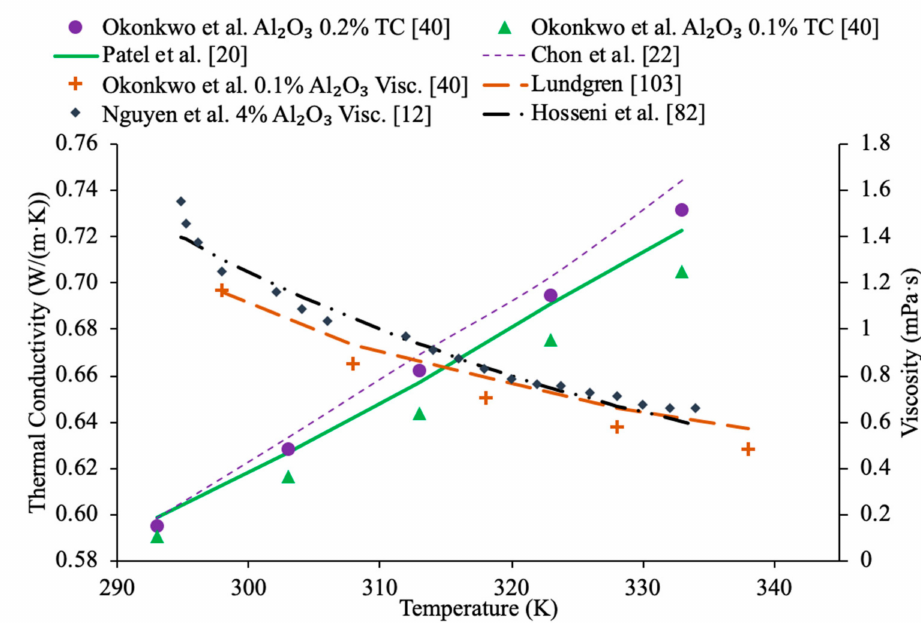
Figure 44. Thermal conductivity (increasing with temperature) and viscosity (decreasing with temperature) for Al 2 O 3 –water nanofluid at 0.1%, 0.2% [70] (40) and 4% concentrations [12] in comparison to various theoretical models